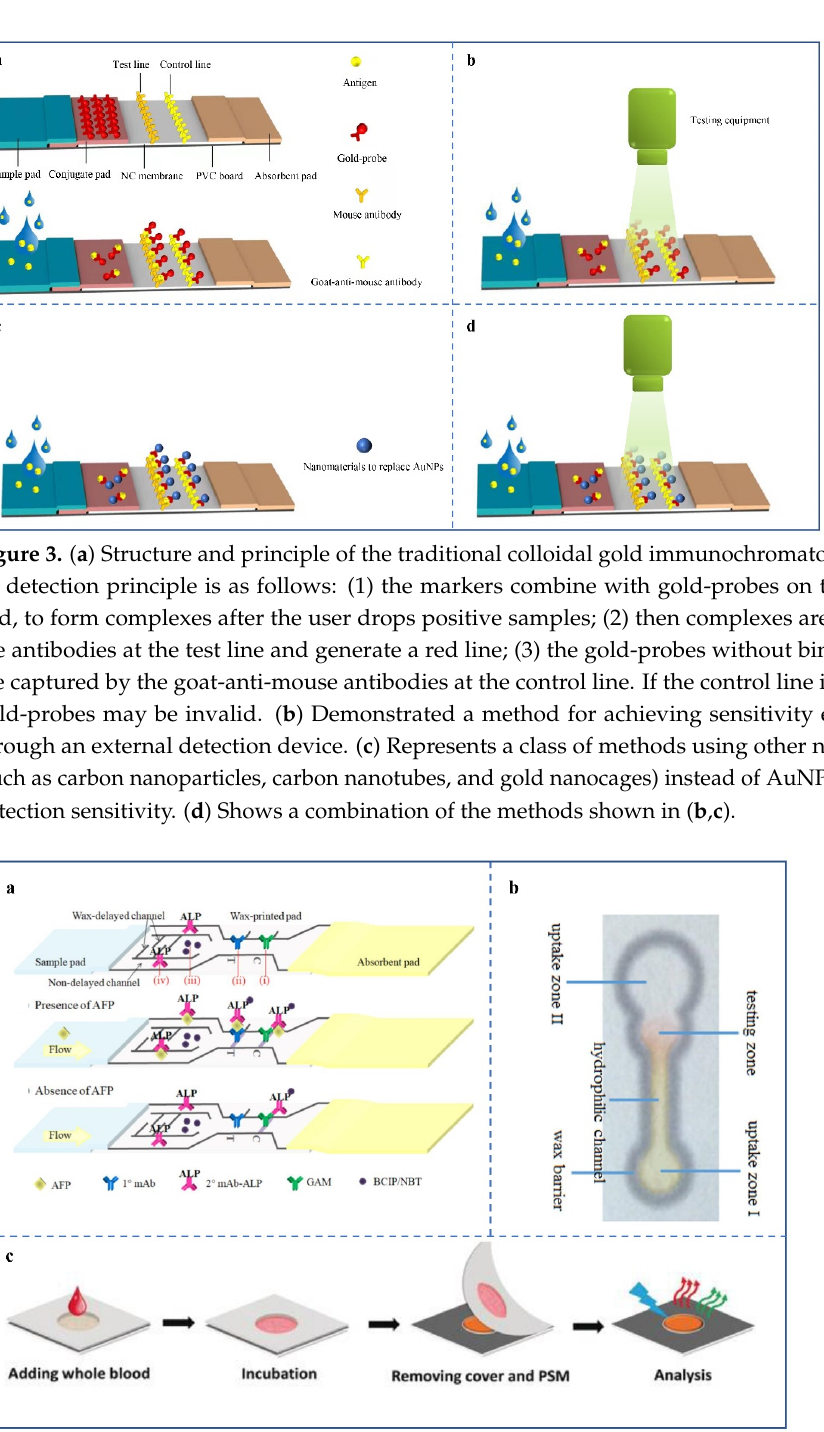
Figure 4. ( a ) Schematic diagram of µ PAD structure and principle [56]. Before dropping the sample, ALP-labeled mouse antibody is in the no-barrier region, and BCIP/NBT is in the wax-formed barrier region. After dropping the positive sample, the ALP-labeled antibody reaches the detection line first, followed by BCIP/NBT, and chromogenic reactions occur. (Copyright © 2022 Published by Elsevier B.V.) ( b ) Channel structure of a μ PAD for dopamine detection [57]. The structure includes a hydrophilic channel, uptake area, and test area around a hydrophobic wax barrier. The uptake area I and test area colors are reaction products (ferric chloride and dopamine) and phenanthroline. (Copyright © 2022 Elsevier B.V. All rights reserved). ( c ) Detection process of 4MC-loaded µ PAD [58]. The device is simple to operate and has a wider range of applications. (Copyright © 2022–2022 John Wiley & Sons, Inc. All rights